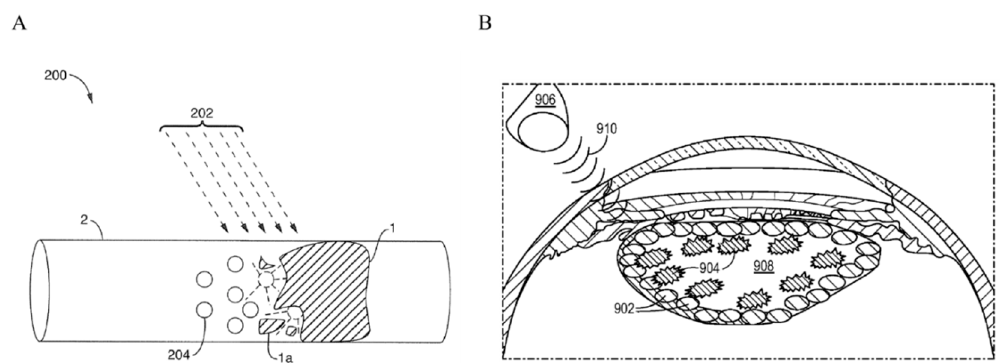
Figure 7. Examples of inventions published as patent applications or patents proposing the use of USMB for the treatment of ocular diseases. ( A ) Sonothrombolysis of a blood clot in a retinal blood vessel. Microbubbles (204) undergo mechanical cavitation when triggered by an externally applied ultrasound beam (202). Oscillations of microbubbles cause the blood clot (1) in the retinal blood vessel (2) to dissolve (1a). Adapted from [180]. ( B ) Fragmentation of cataract using microbubbles. Microbubbles (902) are injected using a thin needle into the lens (908). Ultrasound waves (910) generated by an external source (906) cause the microbubbles to cavitate and fragment the cataracts (904). Adapted from [181].